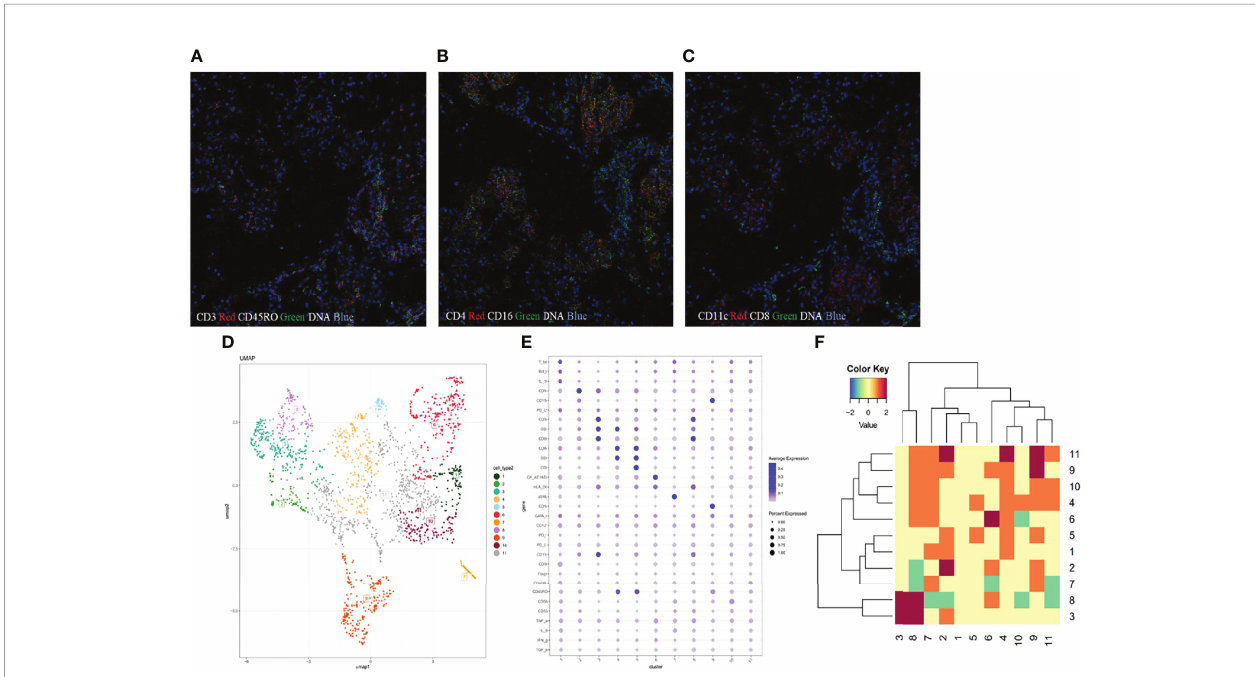
FIGURE 4 | The microenvironment in patients with immune checkpoint inhibitor-related pneumonitis. (A – C) Imaging mass cytometry (IMC) imaging of formalin- fi xed paraf fi n-embedded lung tissue specimen. (D) Statistical t-distributed stochastic neighbor embedding (tSNE) plots were generated to divide the cell populations into 11 clusters according to phenotypic similarity. (E) Heat map analysis of the mean expression of analyzed markers from 11 identi fi ed clusters. The expression levels are indicated by heat colors. (F) Neighborhood analysis revealed cell-to-cell interactions between different